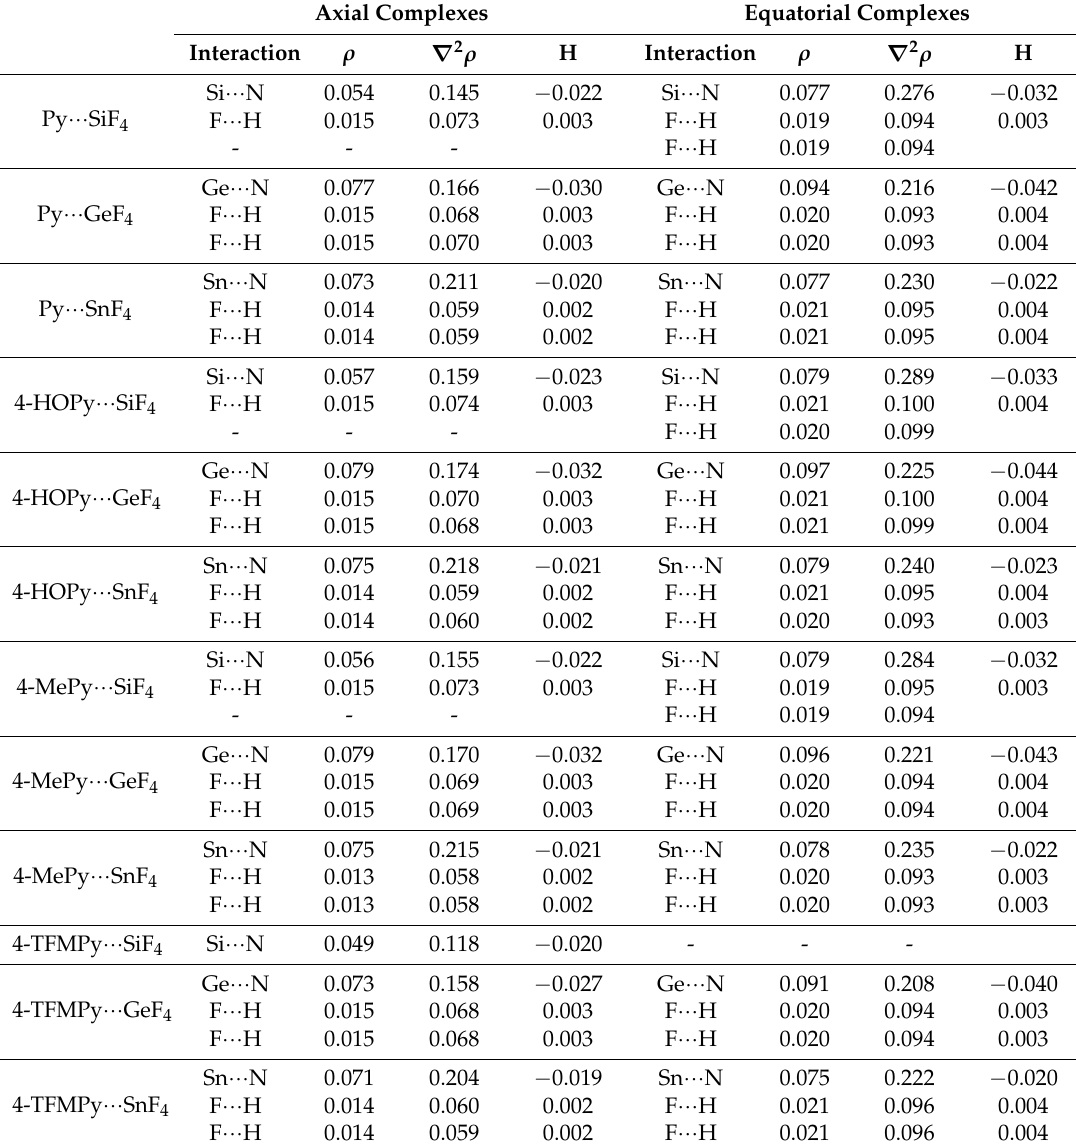
Table 8. AIM bond critical point (BCP) properties: electron density ρ , Laplacian of electron density ∇ 2 ρ (both in atomic units) and total electron energy (H, a.u.) obtained at the MP2/cc-pVTZ